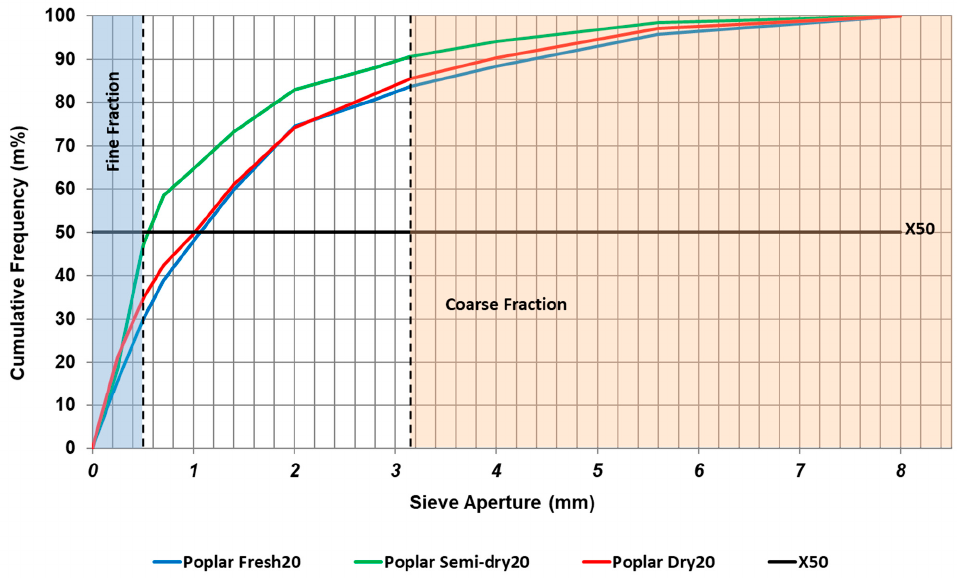
Figure 6. Particle size distribution of fresh, semi-dry, and dry extruded wood chips into fibre extruded at a 20 mm aperture.